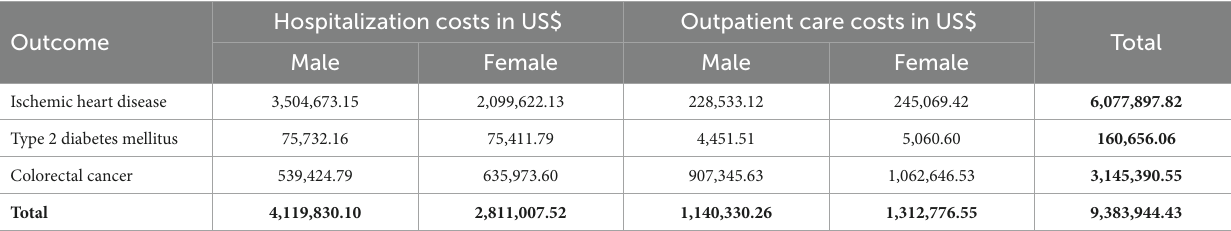
TABLE 1 Total costs of hospitalizations and outpatient procedures for chronic noncommunicable diseases attributable to a diet rich in processed meat to the Unified Health System in Brazil in 2019.